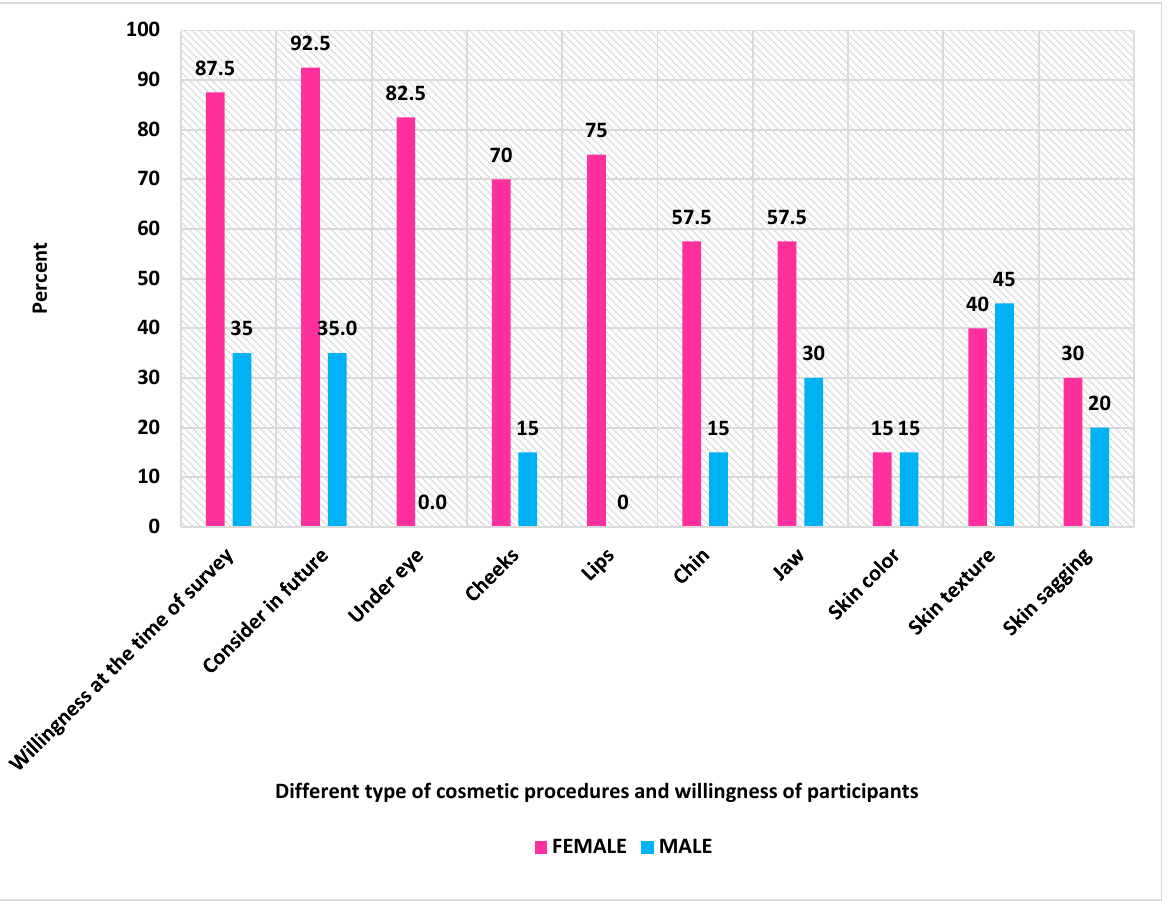
Figure 4. The willingness of participants to undergo different cosmetic procedures at the time of the survey and to consider it in the future.